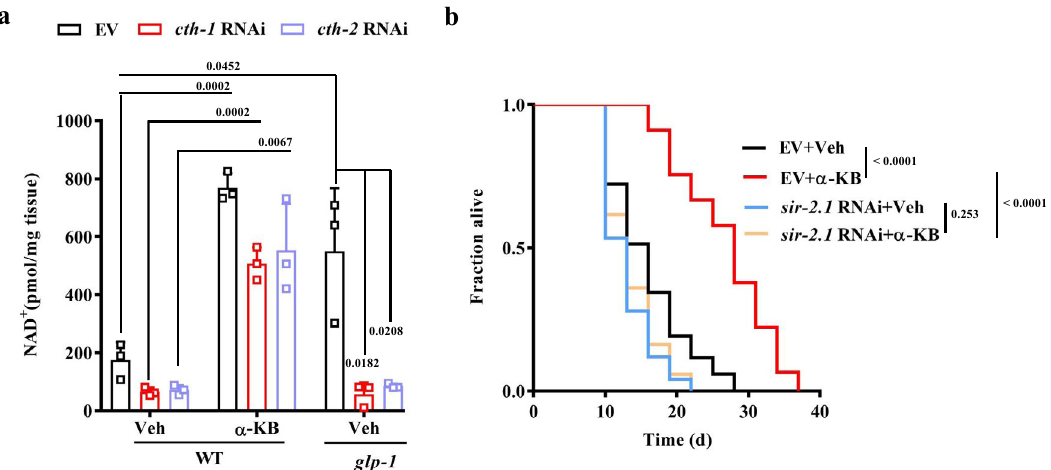
Fig.2|Lifespanextensionby α -KBdependsontheNAD + -SIR-2.1pathway.a The contents of NAD + were increased in α -ketobutyrate ( α -KB, 500 μ M) -treated wild- type (WT) worms or glp-1 ( e2141ts ) mutants. Knockdown of either cth-1 or cth-2 by RNAi reduced the levels of NAD + in germline-de fi cient worms back to those of WT worms. Veh vehicle. Data were presented as mean values±SEM of three